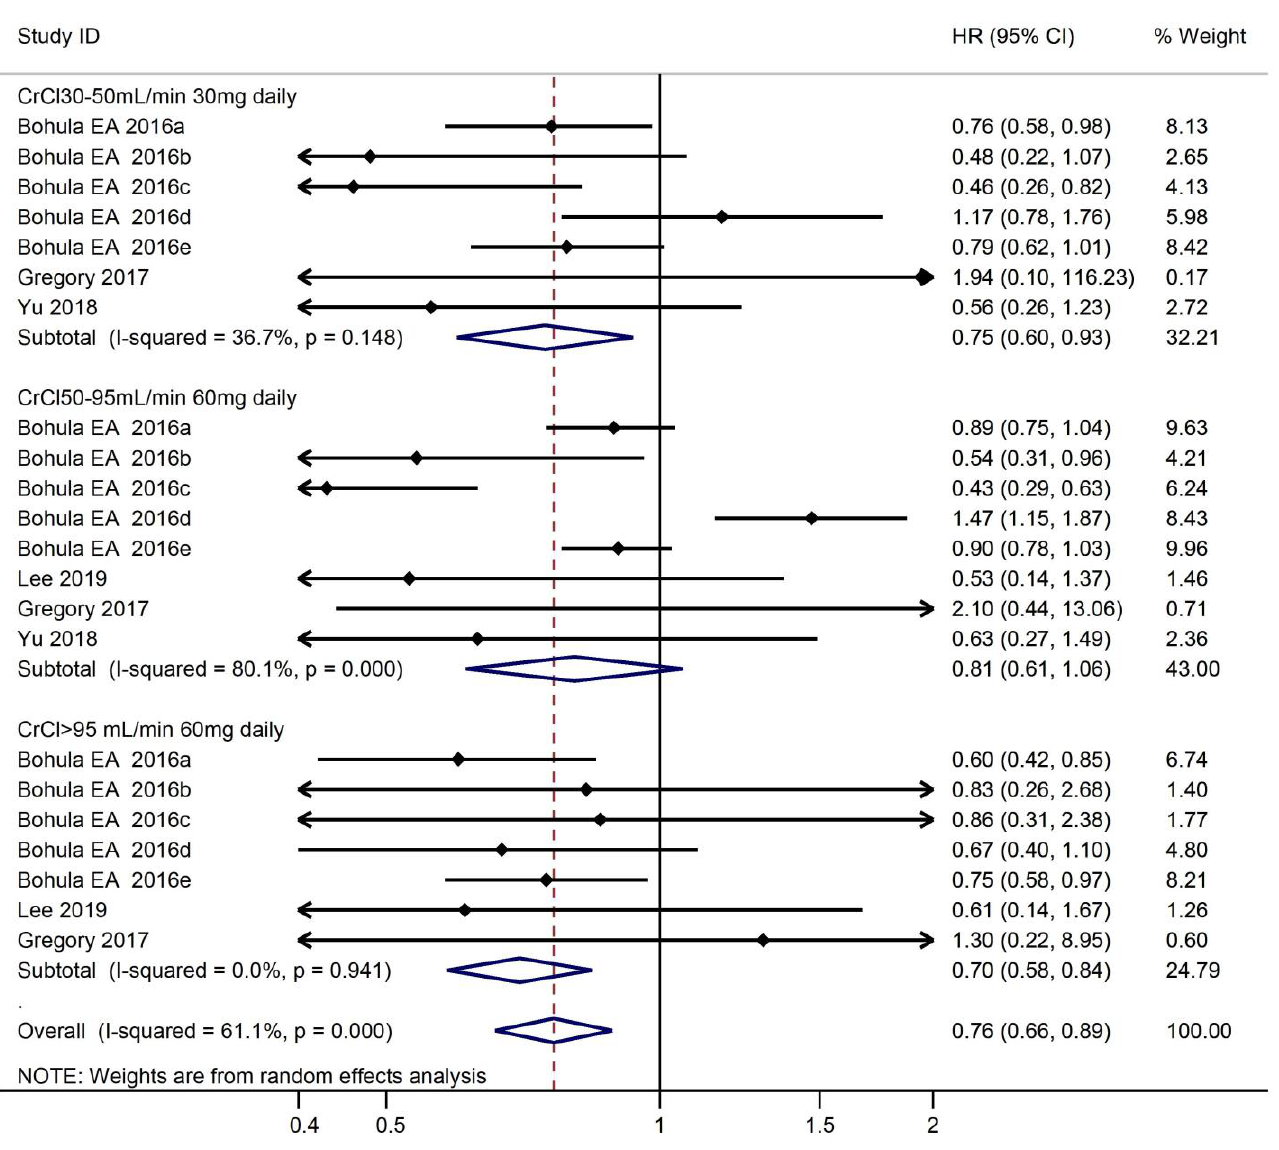
Figure 5. Risk of bleeding and use of edoxaban versus warfarin in relation to CrCl.